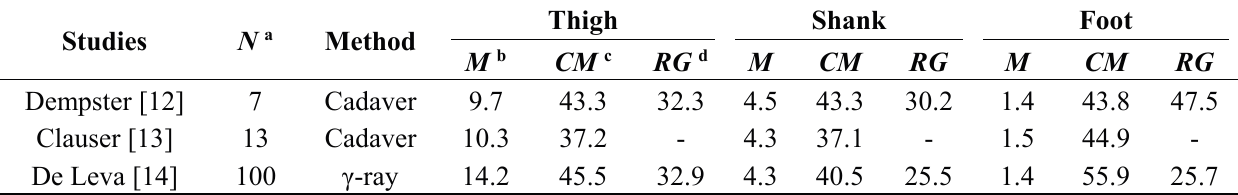
Table 1. BSIP estimation